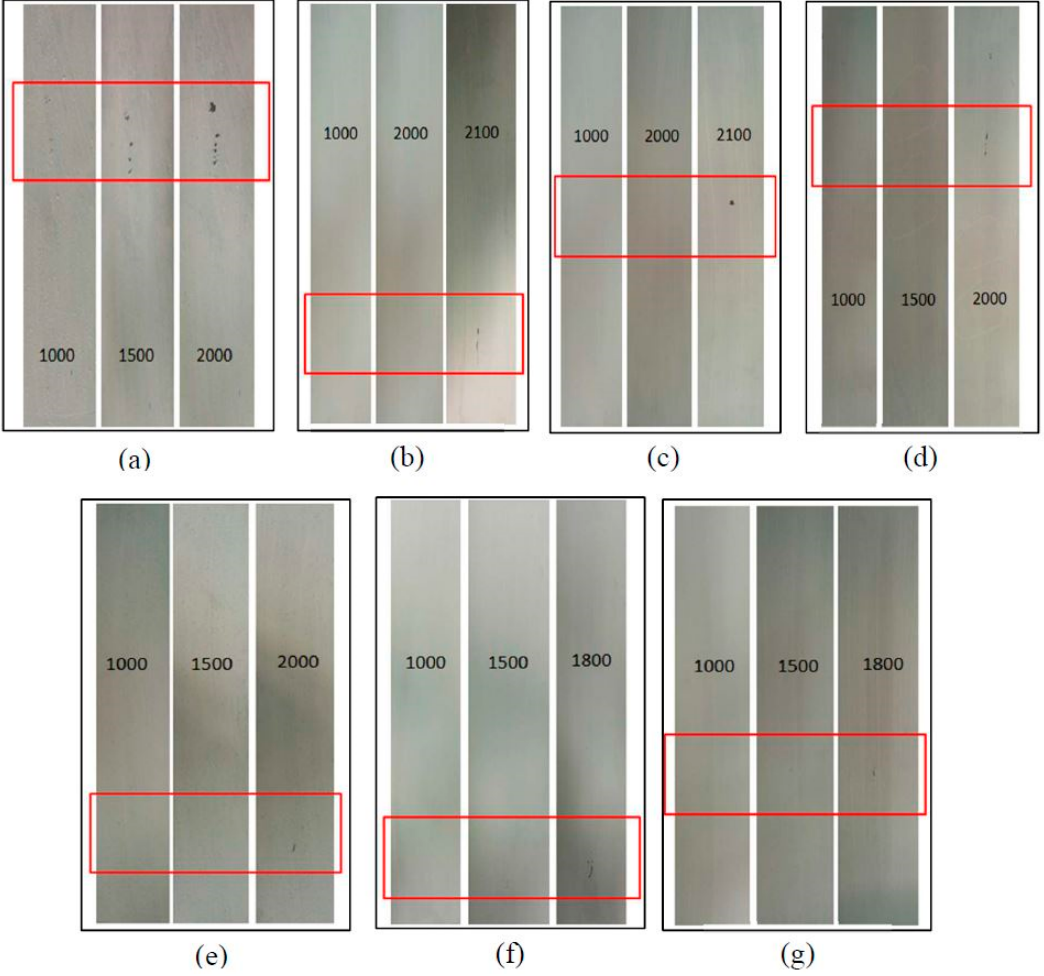
Figure 9. The scrub resistance of coatings with shell powder calcined at different temperature. ( a ) as-received; ( b ) 100 °C; ( c ) 200 °C; ( d ) 300 °C; ( e ) 400 °C; ( f ) 500 °C; ( g ) 600 °C.